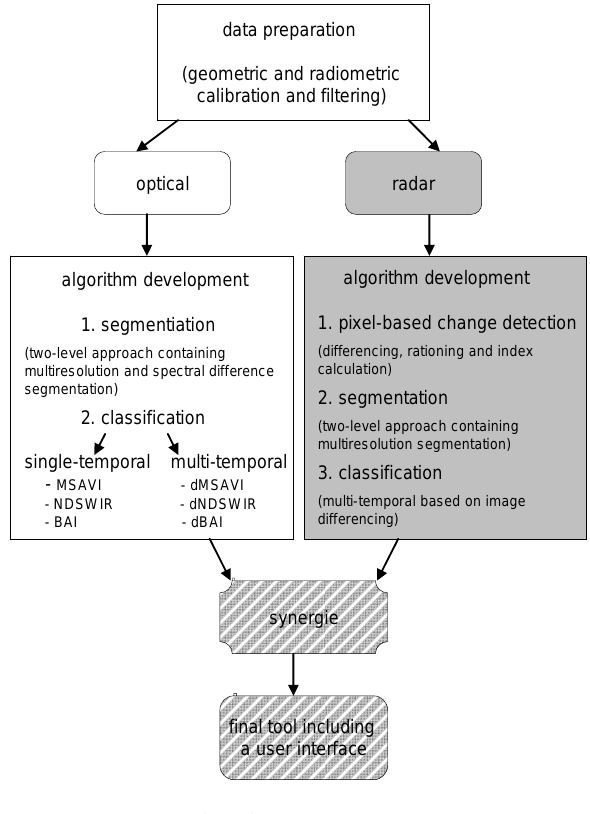
Figure 2. Workflow for optical and radar burned area